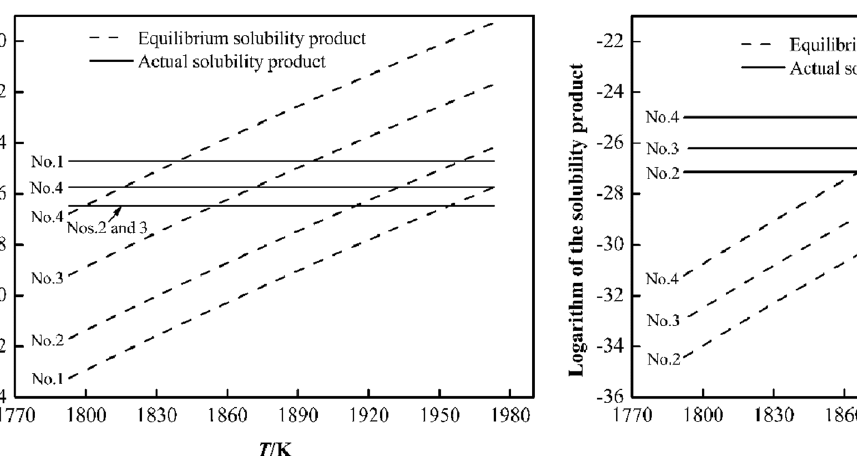
Figure 3: Logarithm of the solubility product as a function of temperature for Al 2 O 3 in the liquid steel.